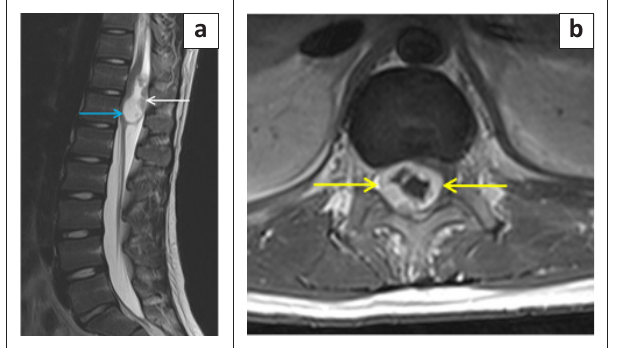
FIGURE 2: Intramedullary myxopapillary ependymoma in a 15-year-old boy. Sagittal T2-weighted (a) and axial contrast-enhanced T1-weighted; (b) images demonstrate a well-circumscribed mass (white arrow in 2a) in the conus with cystic degeneration (blue arrow in 2a), with an exophytic growth pattern and avid enhancement of the solid components of the mass (yellow arrows in 2b).